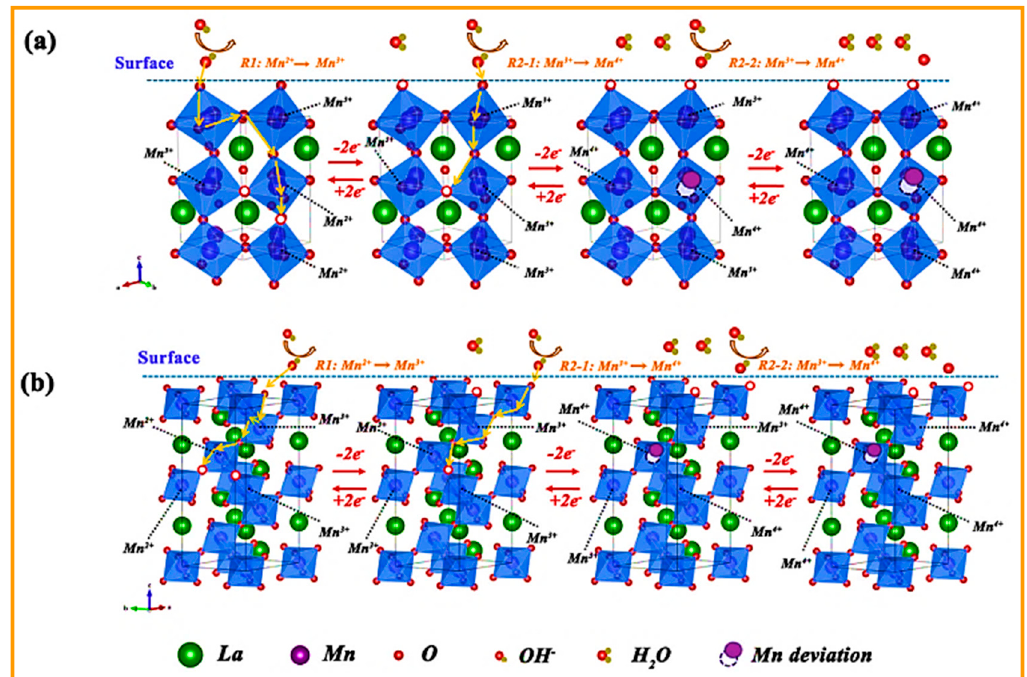
Figure 24. Crystal structures and the corresponding oxygen intercalation processes of A-site substituted compositions: ( a ) LCM; ( b ) LSM. Reprinted with permission from [466], Copyright 2020, Elsevier.